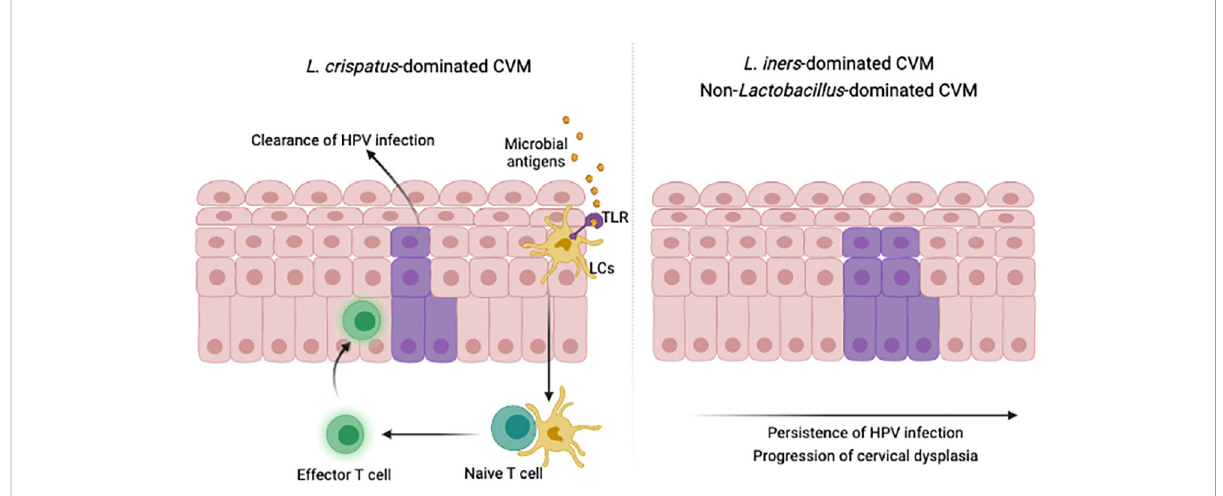
FIGURE 3 CVM modulate immunity to promote HPV clearance. Microbial key players in speci fi c cervicovaginal environment activate suppressed LCs, migrating to lymph nodes, presenting antigens and attracting effector T cells to infected epidermis. This illustration was created in BioRender.